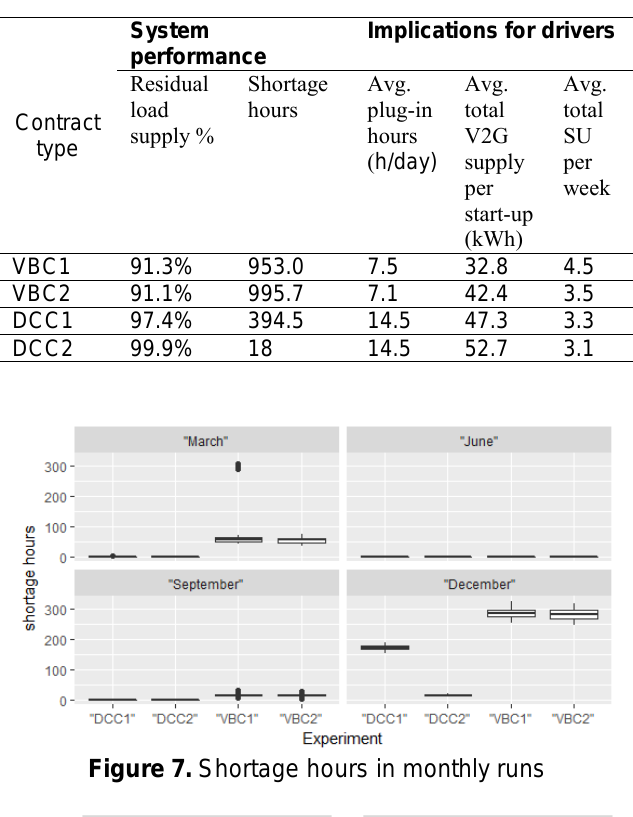
Table 3. Yearly results